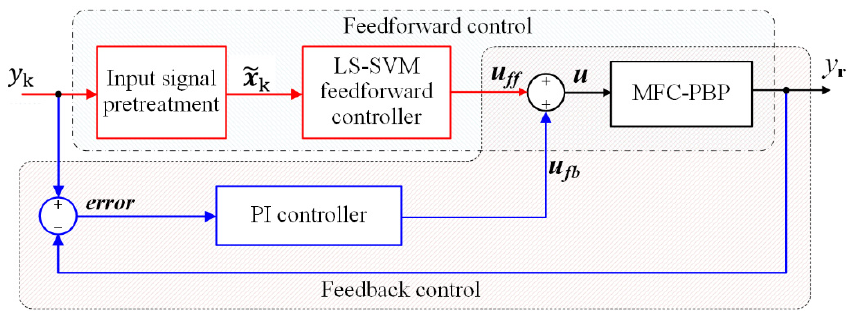
Figure 13. Displacement tracking control diagram of LS-SVM feedforward compensator plus PI feedback control.